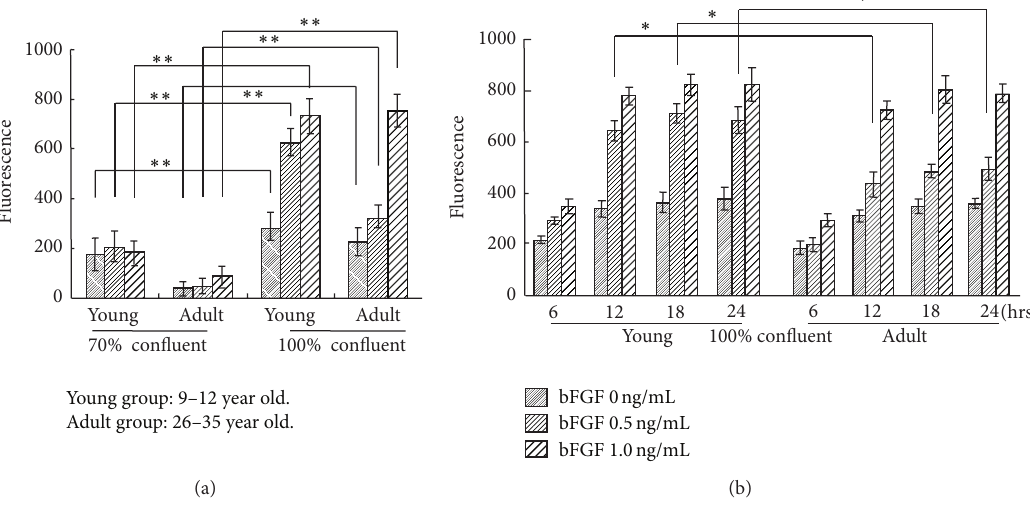
Figure 3: Effect of the activation of bFGF on the induction of apoptosis in cultured human GF. (a) Comparison of caspase-3 activity between 70% confluent and 100% confluent groups. (b) Time course of caspase-3 activity in 100% confluent group. Error bars indicate a standard deviation. 𝑁 = 8 , ∗ 𝑃 < 0.05 , ∗∗ 𝑃 < 0.01